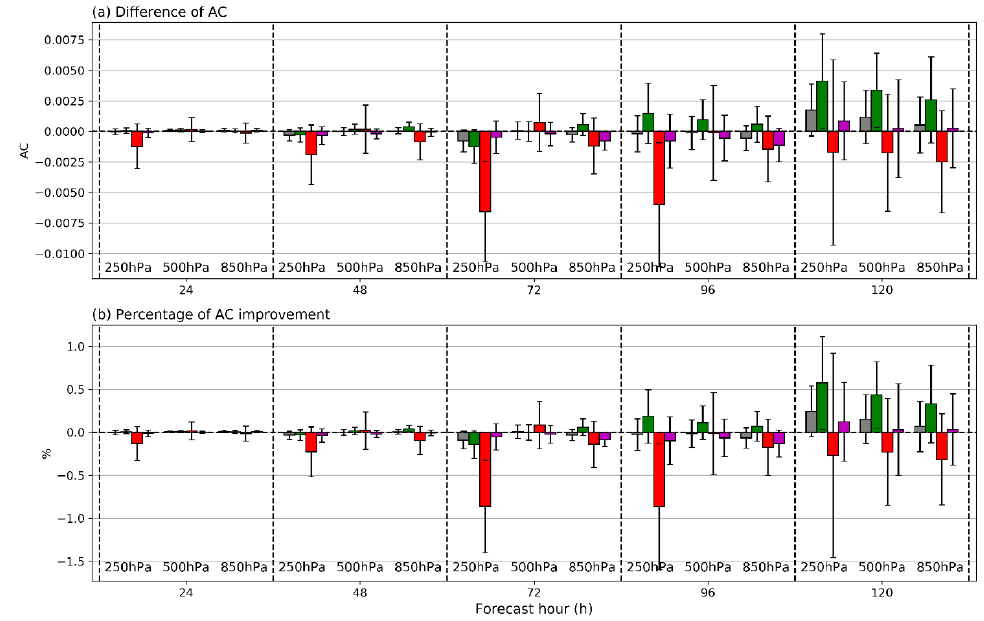
Figure 15. The ( a ) mean and ( b ) normalized difference of AC of 250 hPa, 500 hPa, and 850 hPa temperature forecast up to 120–h forecast hours between the latency_5m and latency_20m runs. Grey, green, red, and magenta boxes indicate the results over the Global, Northern Hemisphere, Tropic, and Southern Hemispheres, respectively. Vertical bars representing 95% confidence level of the uncertainty are overlaid.